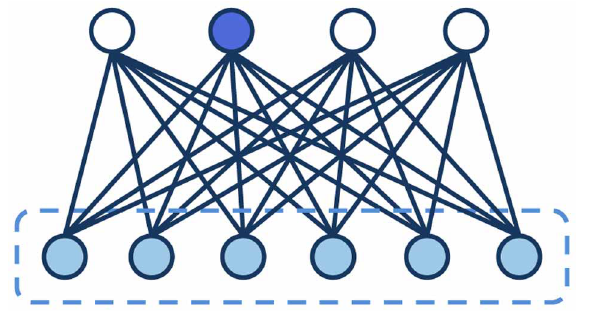
FIGURE 2 | Graphical representation of a Restricted Boltzmann Machine. The dashed line highlights the Markov blanket of the blue hidden unit, which corresponds to the whole layer of visible